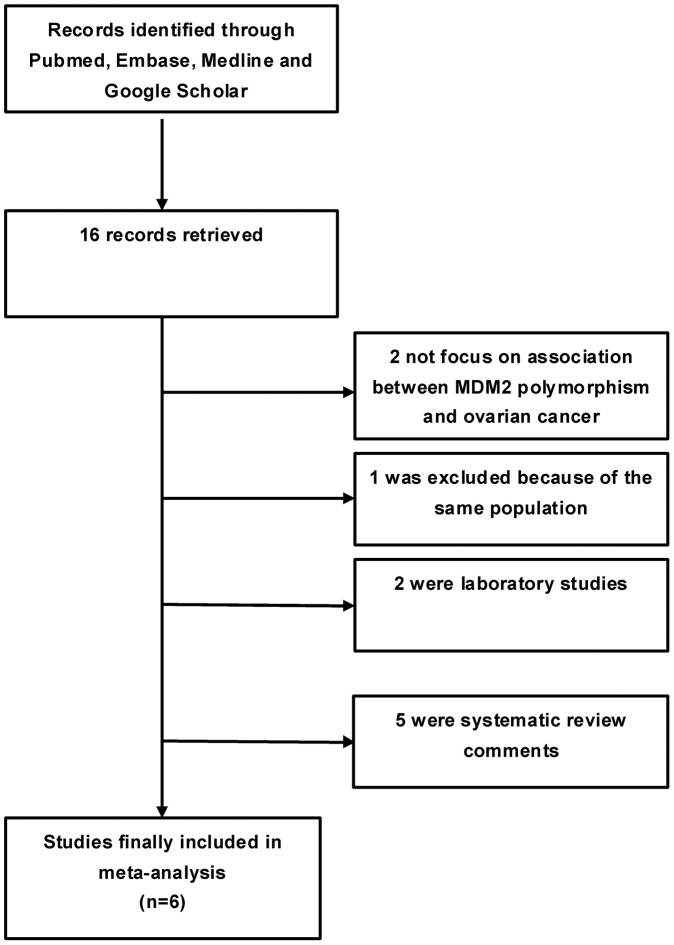
Flow chart of study study selection based on the inclusion and exclusion criteria.